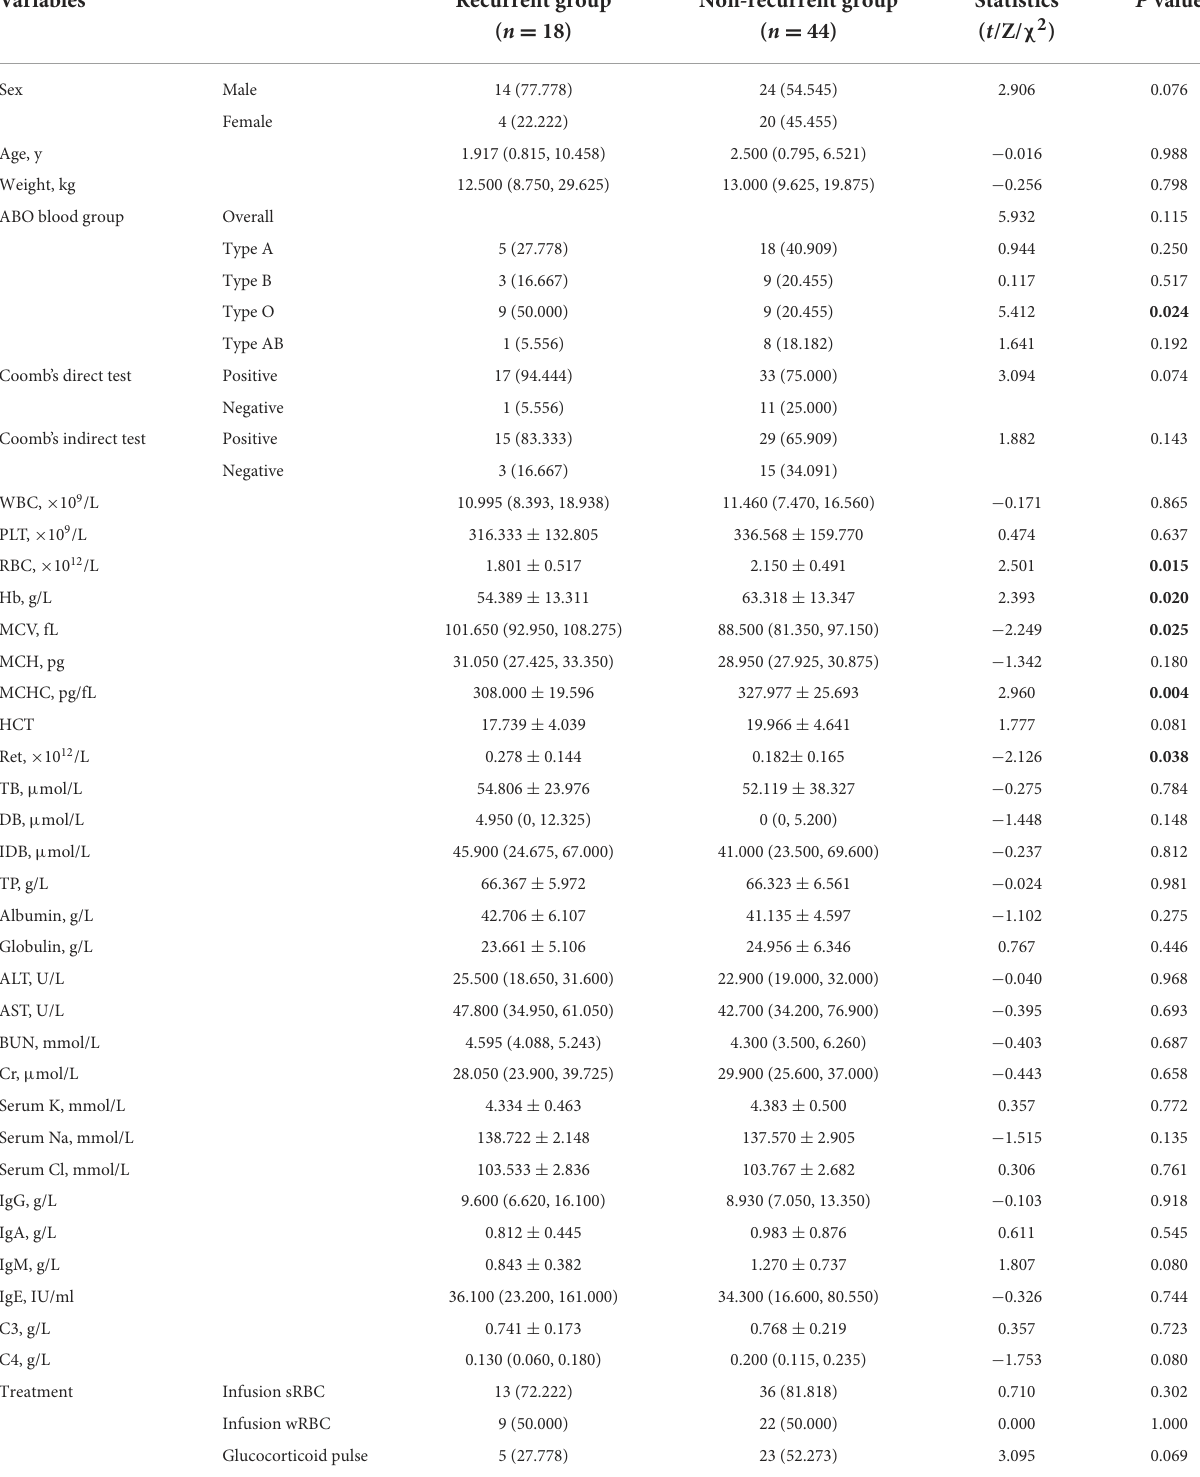
TABLE 1 Baseline characteristics of study